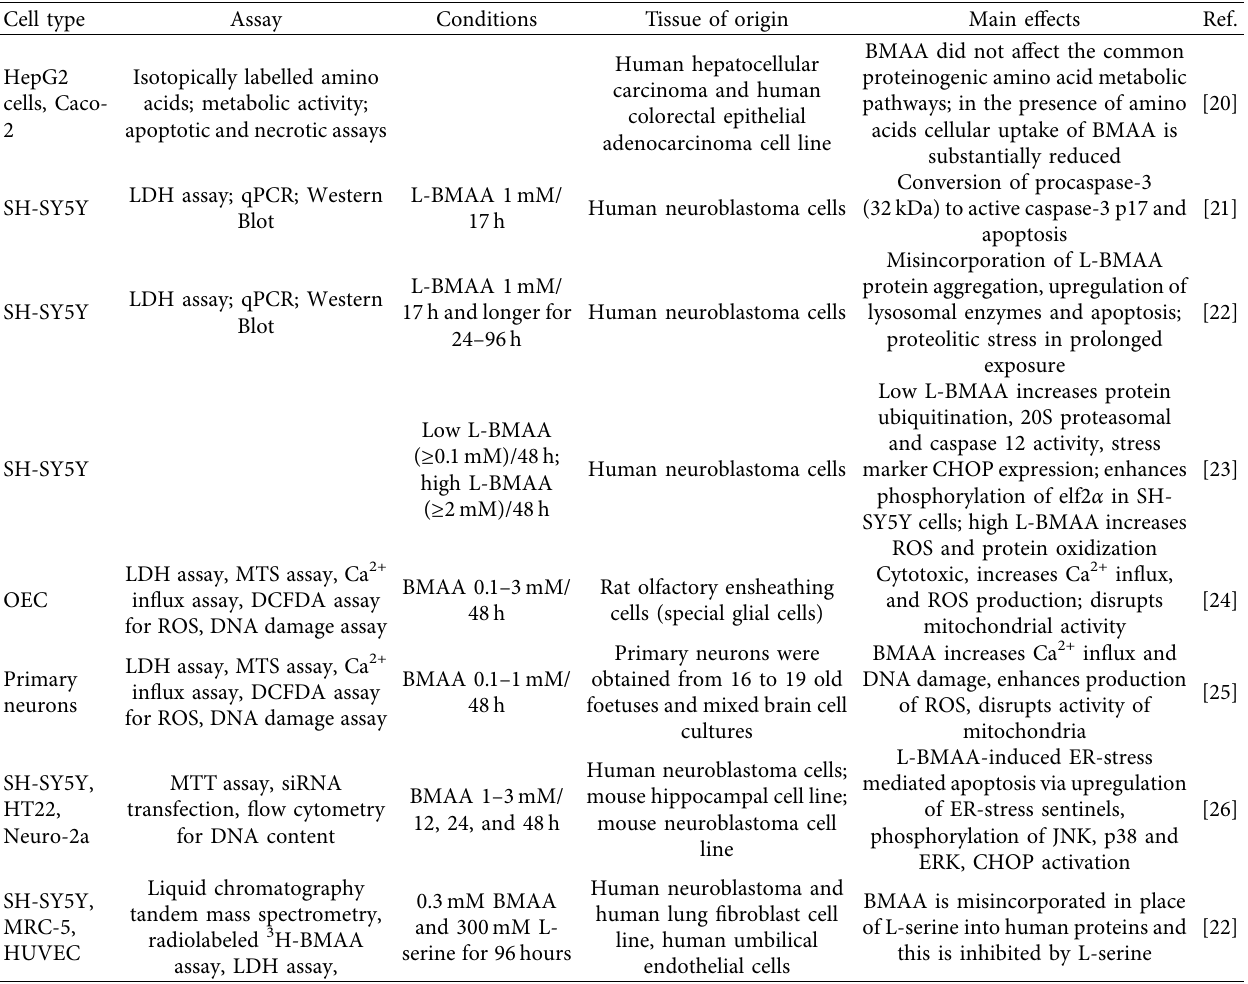
Table 3: Cytotoxicity of